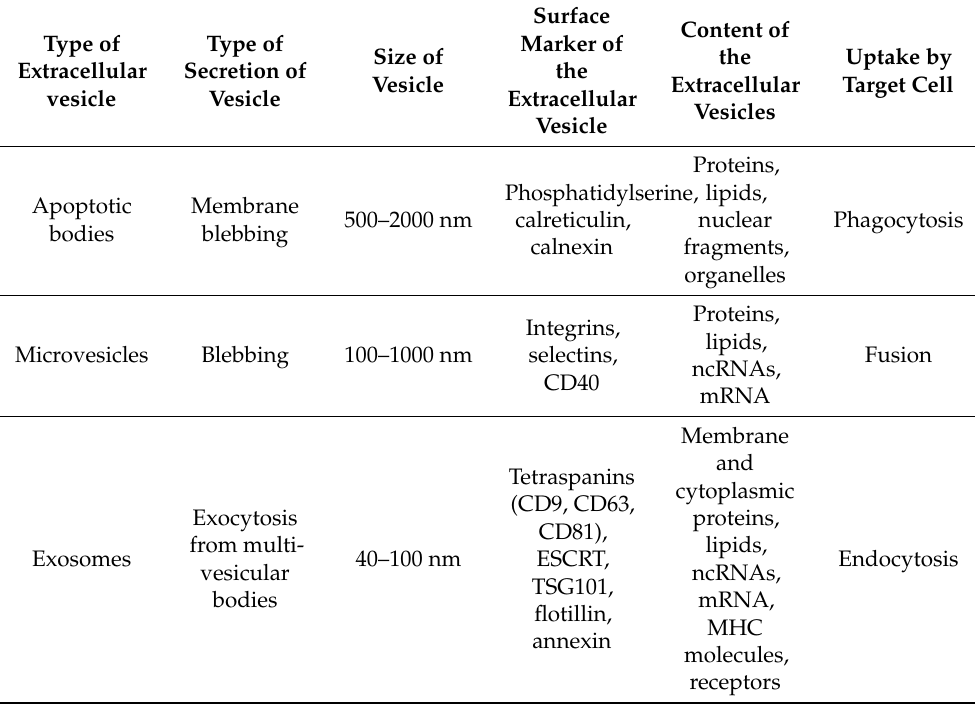
Table 1. Characterization of MSC-derived vesicles according to origin, size, surface marker, content and uptake mechanism by the target cells (according to [51]). Abbreviations: ESCRT, endosomal sorting complex required for transport; TSG101, tumor susceptibility gene 101